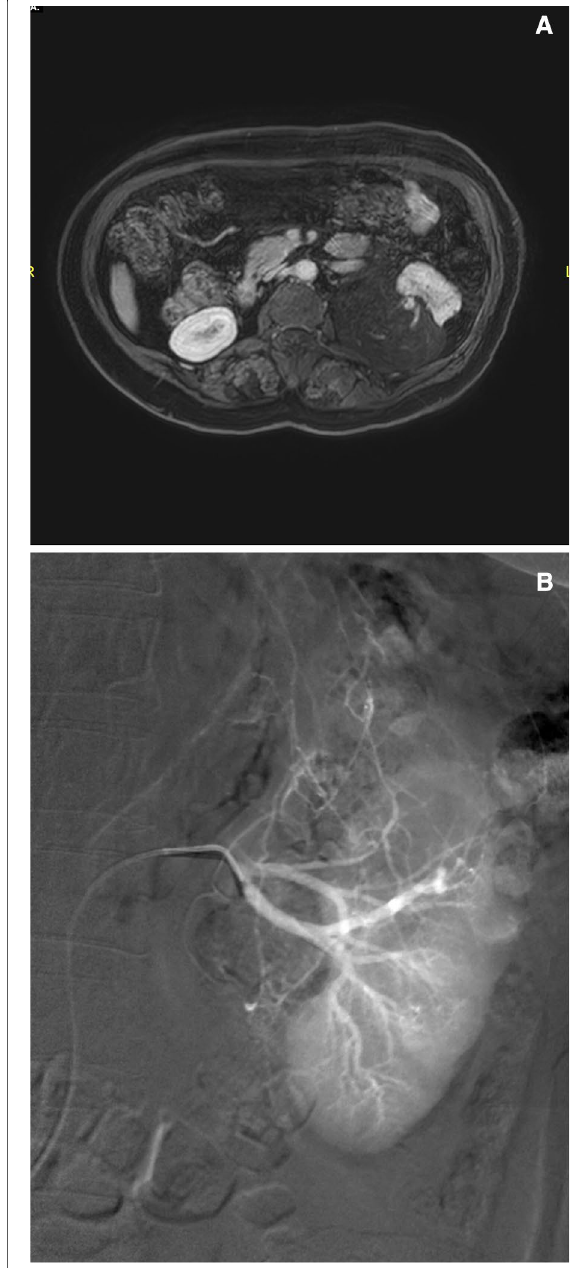
Fig. 2 Axial MRA in 43‑year‑old female patient with spontaneous hematuria showing a large left renal fat containing mass displacing the kidney anteriorly with evidence of micro‑aneurysm inside the lesion ( A ). Selective left renal angiography of the same patient revealed the same findings ( B ) Princeton, NJ, USA), Gadodiamide (Omniscan 0.5 mmol/ (0.2 mmol/kg of Magnevist; Schering Health Care, USA).